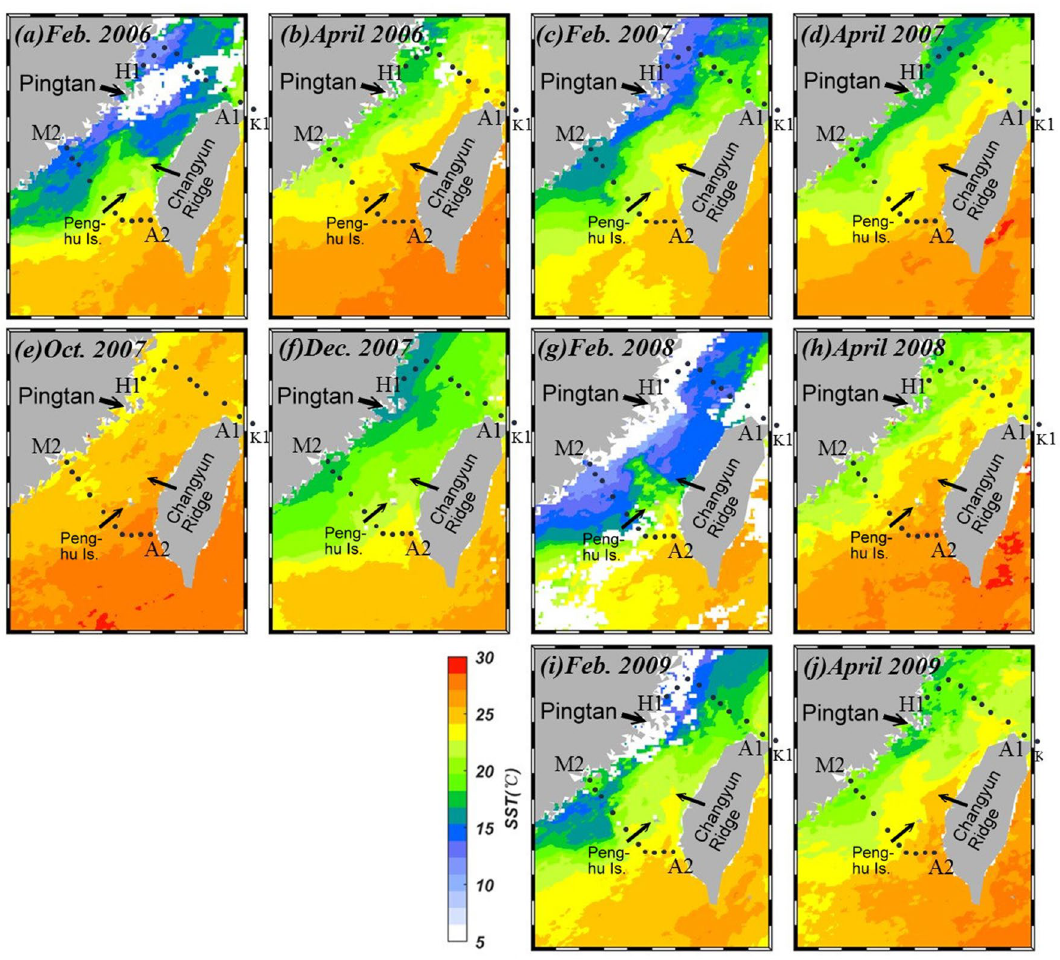
Figure 4. Mean monthly SST in ( a ) Feb. 2006, ( b ) April 2006, ( c ) Feb. 2007, ( d ) April 2007, ( e ) Oct. 2007, ( f ) Dec. 2007, ( g ) Feb. 2008, ( h ) April 2008, ( i ) Feb. 2009 and ( j ) April 2009 in the vicinity of the study area (map generated by using the m_map toolbox in MATLAB 2019a; https ://www.mathw The warmest water found at Stn. C1 in our northern transect is, therefore, originated from the southern Taiwan Strait. This water has a very low NO 3 + NO 2 value (Fig. 2d) so it lends support that this water is from the south instead of the retreating, remnant, ECS water. On the other hand, the cooler waters west of Stn. D1 have NO 3 + NO 2 concentrations as high as 18 μmol L −1 at the surface. Since this high value is much higher than bot- tom waters found anywhere in our northern cross-section (Fig. 2d) it can not come from upwelling. The only logical explanation is that it is the retreating CDW from the 2007/2008 winter. Figure 4a,c,i shows the satellite SST images collected for the normal Feb. of 2006, 2007 and 2009. Waters in the ECS were much colder in the La Niña Feb. of 2008 (Fig. 4g), the northern SCS water was also cooler in 2008. Because of the stronger northeast monsoon, cold waters extended farther south along the coast of China in 2008. Figure 3b shows the θ/S plot of winter and spring data from various cruises near Stn. E1 of our study. Indeed, the coldest waters were found in 2008. These waters were among the freshest, in accordance with the notion that the CDW extended southward the most in 2008. Compared to the SST the water transparency is a much more useful tool in identifying coastal waters in seasons when waters are uniformly warm in general 48 . The satellite Secchi Disk depth images for the months of interest between Feb. 2006 and April 2009 are shown in Fig. 5a–j. Starting from Oct. 2007, half a year before our cruise (Fig. 5e) a band of high turbidity water exists along the coast of China when the SST still does not show much contrast across the Taiwan Strait. A narrower band of turbid water also exists off the western coast of central Taiwan. In the Taiwan St. proper is less turbid water (shown in light blue and green in Fig. 5e). Kuro- shio and SCS waters were very clear, as shown by blue in Fig. 5e. The low turbidity water can be seen to extend northward in the southeastern Taiwan Strait but it is forced to turn toward the west south of the Changyun Ridge. It then turned northward again west of the ridge and continued northeastward following the depression in the northeastern Taiwan Strait. The transparency image in Dec. 2007 (Fig. 5f) is similar to the Oct. image with all features mentioned above intact, except that the high turbidity coastal bands expanded in width and that the turbidity was high on top of the Changyun Ridge. By Feb. 2008 the turbid band along the coast of China expanded even more (Fig. 5g). Similar